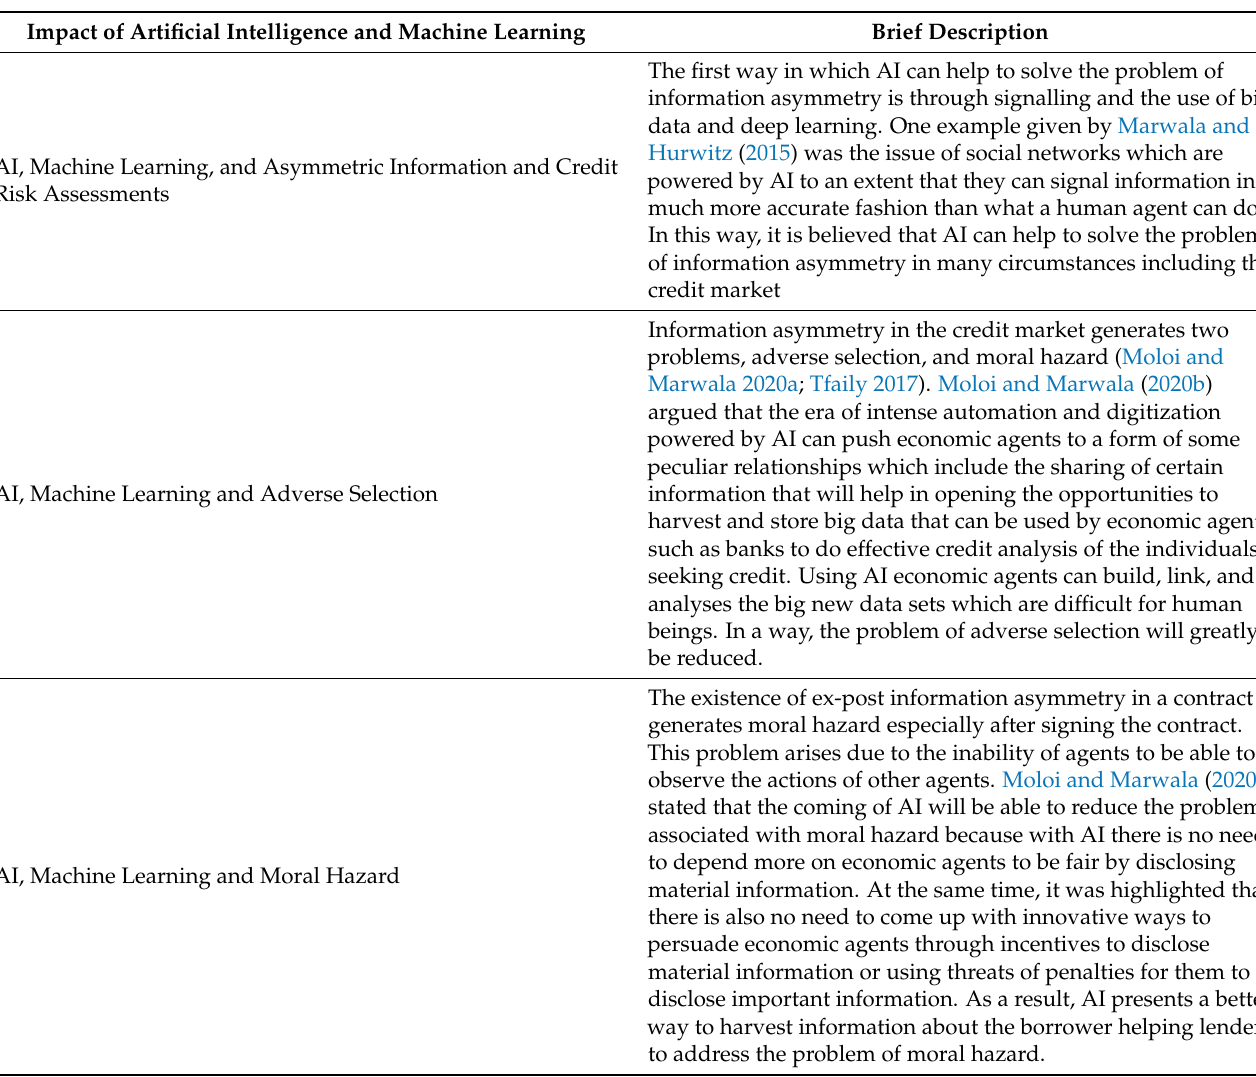
Table A1. Summary of the Impact of Artificial Intelligence and Machine Learning in Credit Risk Analysis. Impact of Artificial Intelligence and Machine